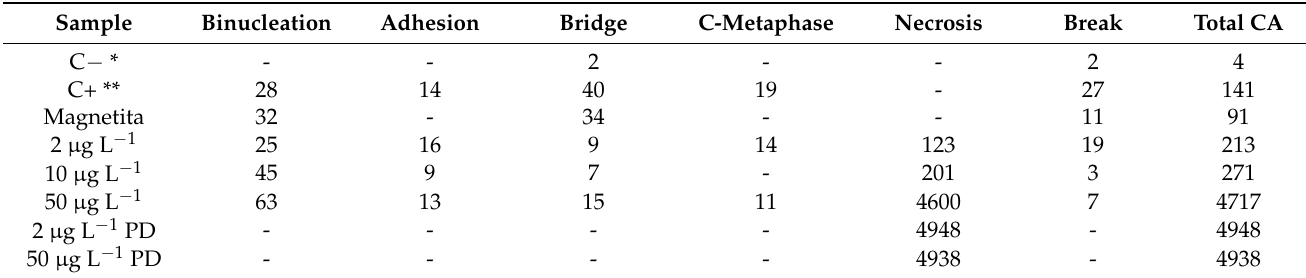
Table 6. Chromosomal aberrations found in analysis.